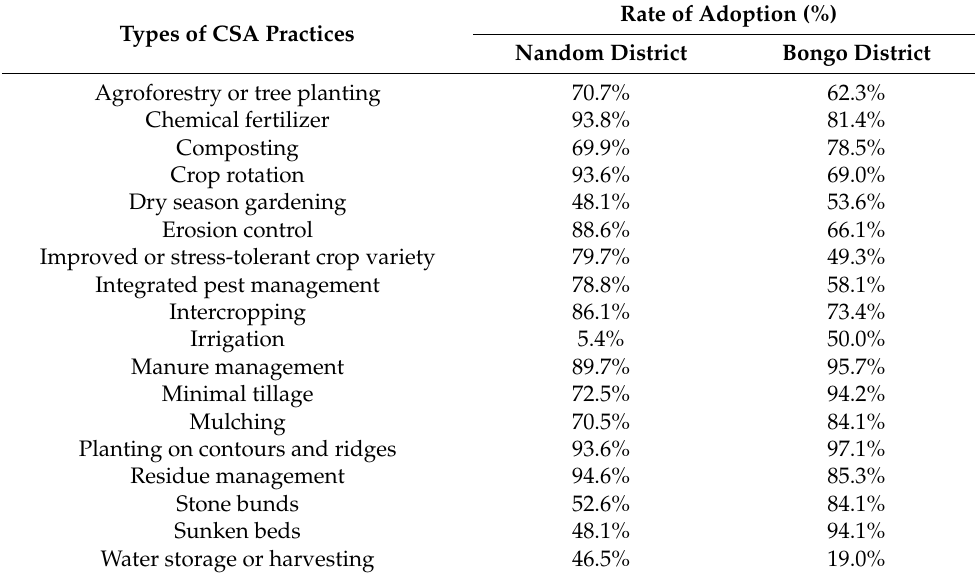
Table A2. Rate of Adoption of the CSA